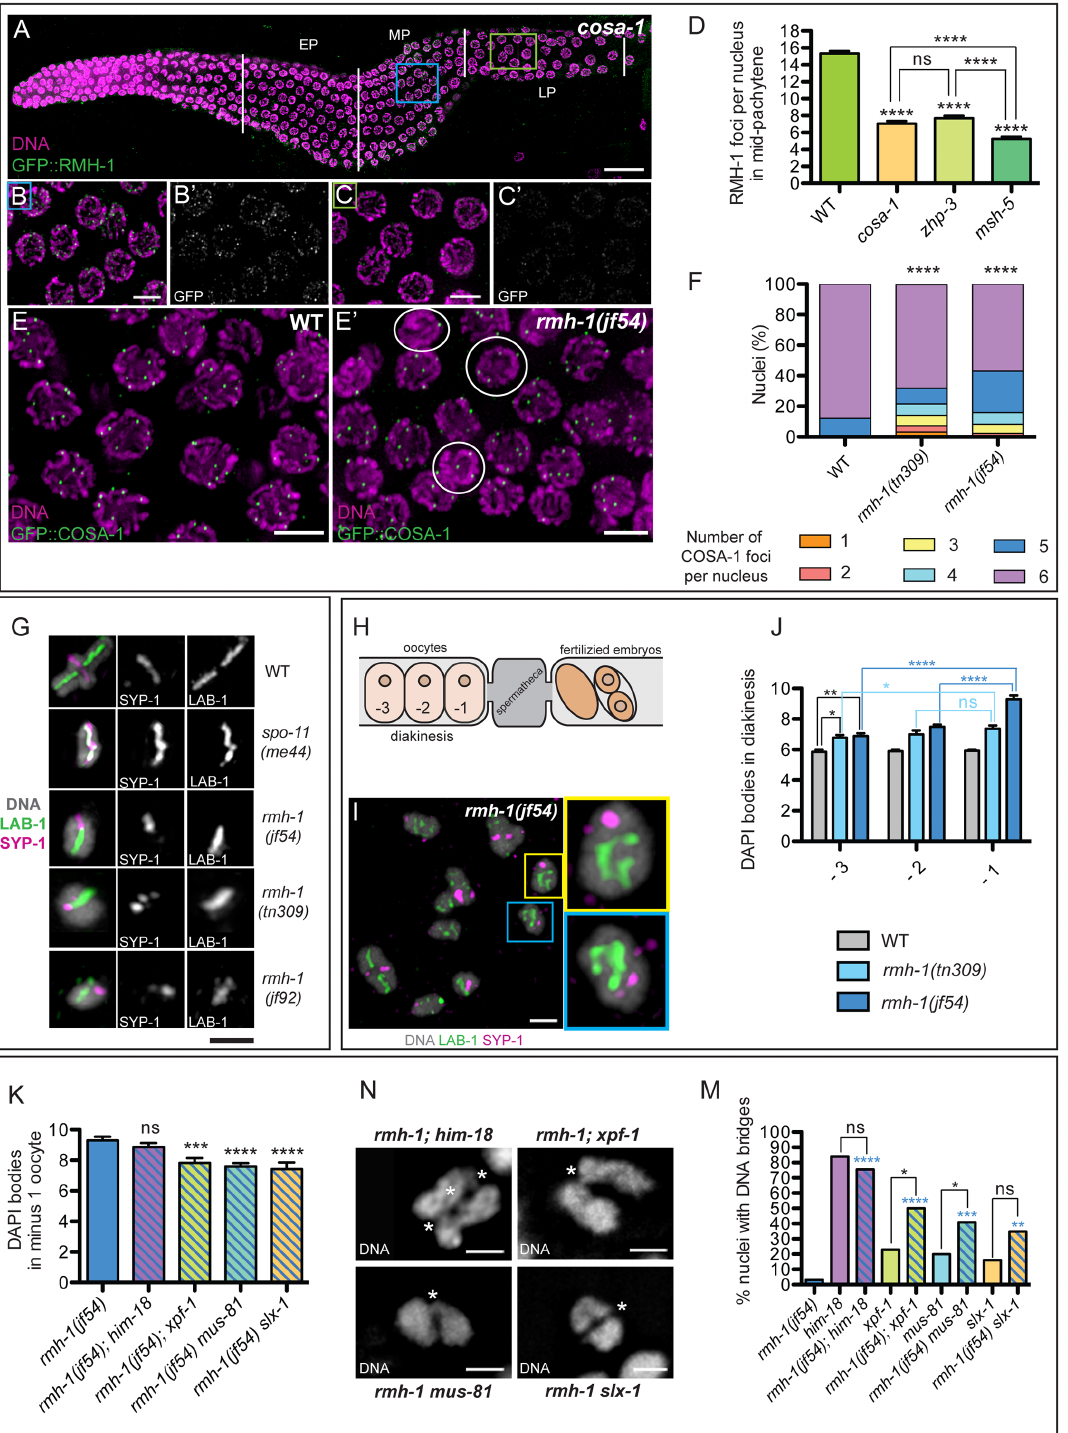
Fig 4. RMH-1 in the context of CO formation. (A – C) RMH-1 localization in a cosa-1 mutant. In mid pachytene (MP), RMH-1 foci are less abundant and smaller than in wild-type (WT, blue square, B and B 0 ) and are barely detectable in late pachytene (LP) (green square, C and C 0 ). (D) Quantification of average RMH-1 foci per nucleus in MP in the WT ( n = 205) and cosa-1 ( n = 214), zhp-3 ( n = 179), and msh-5 ( n = 137) mutants. In three CO-defective mutants, foci numbers were significantly reduced ( p < 0.0001). Data are represented as mean +/- SEM. (E) In WT, most LP nuclei exhibit six COSA-1::GFP foci. (E 0 ) In rmh-1(jf54) , nuclei with fewer than five COSA-1 foci (white circles) are observed. (F) Stacked bar graph showing the percentage of late pachytene